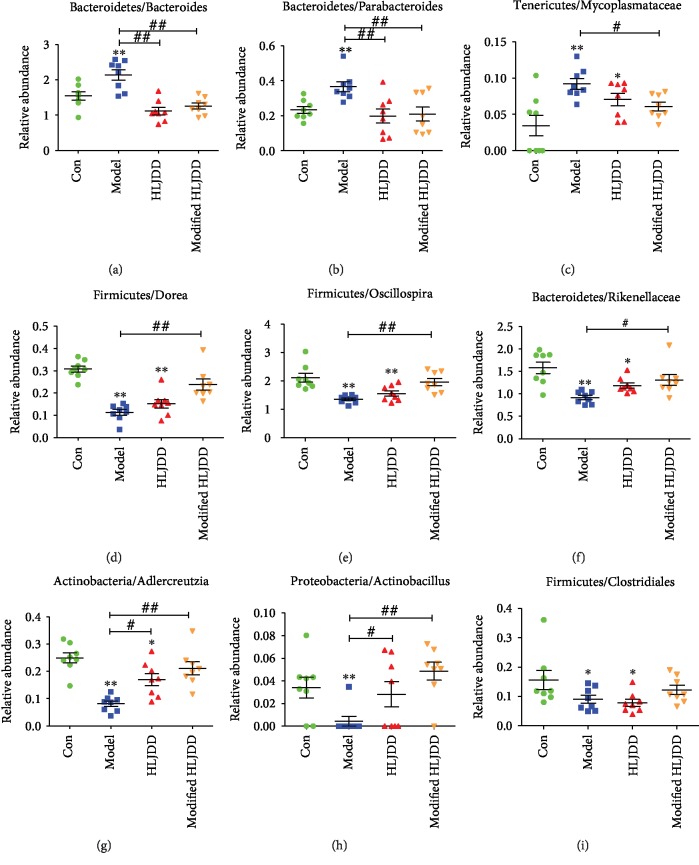
Differential microbiota upon HLJDD and modified-HLJDD treatments in an AD model. (a–i) Top-ranked differential microbiota among the four groups is shown. n = 8 per group. Results are expressed as the mean ± SEM. ∗∗p < 0.01, ∗p < 0.05 vs. control group; ##p < 0.01, #p < 0.05 vs. model group. Statistical significance was determined by one-way ANOVA and Bonferroni tests as post hoc comparisons.